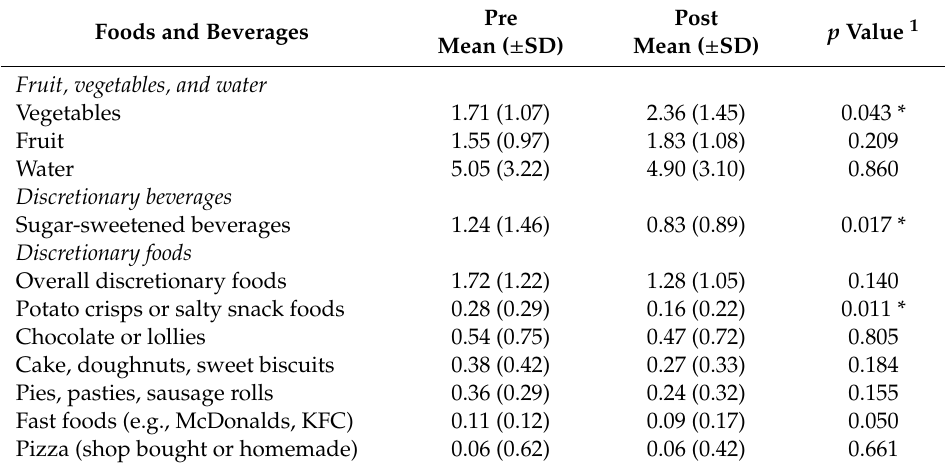
Table 5. Average intake of selected food and beverages (no. serves / day) ( n = 21).